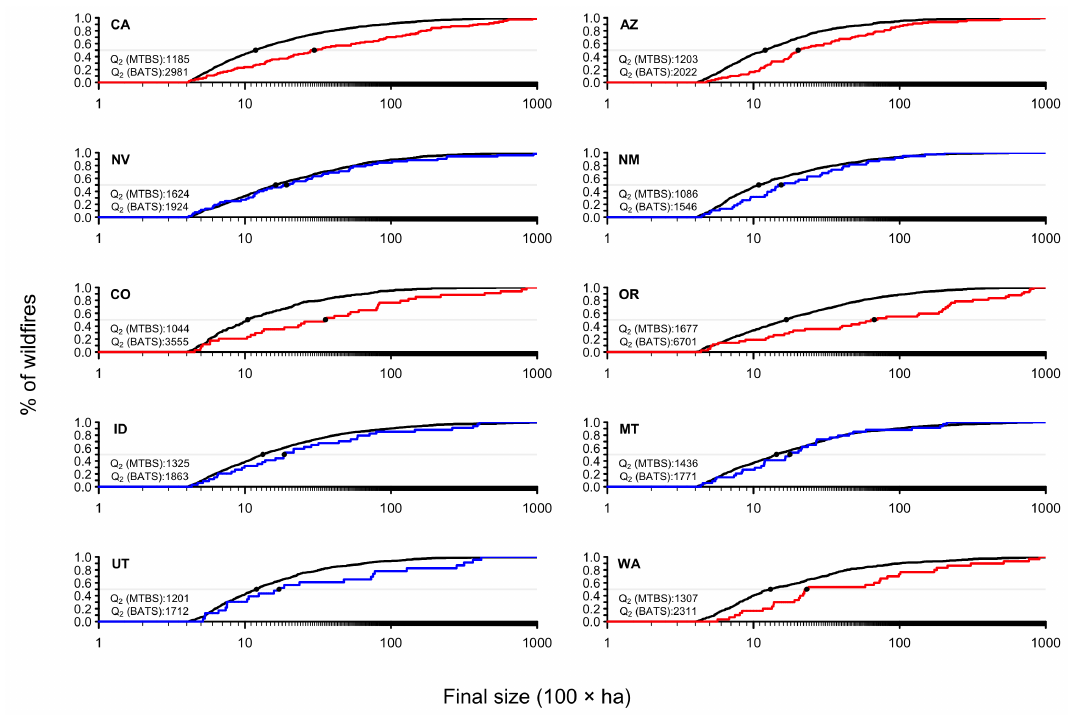
Figure 5. Cumulative distribution functions of wildfire size derived from MTBS and from WoMBATS. The former is colored black, and the latter is colored blue or red depending on its statistical distance from the MTBS data. Specifically, if no detectable difference can be found in the two size distributions, as quantified via a Kolmogorov–Smirnov using a critical p -value of α = 0.05, the cumulative distribu- tion function is colored blue. Otherwise it is colored red. Median values from both data sources are listed in the bottom left and are identified with black